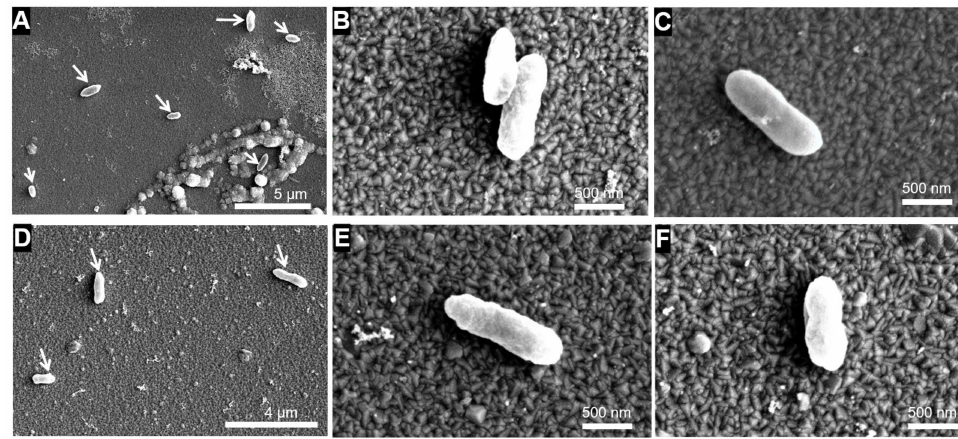
Figure 7. Scanning electron microscopy (SEM) images of A. ferrooxidans cells incubated with H 2 /CO 2 and Fe 3+ as the electron donor, carbon source and electron acceptor in the absence of regolith simulant under Earth gravity ( A – C ) and simulated microgravity ( D – F ). White arrows indicate